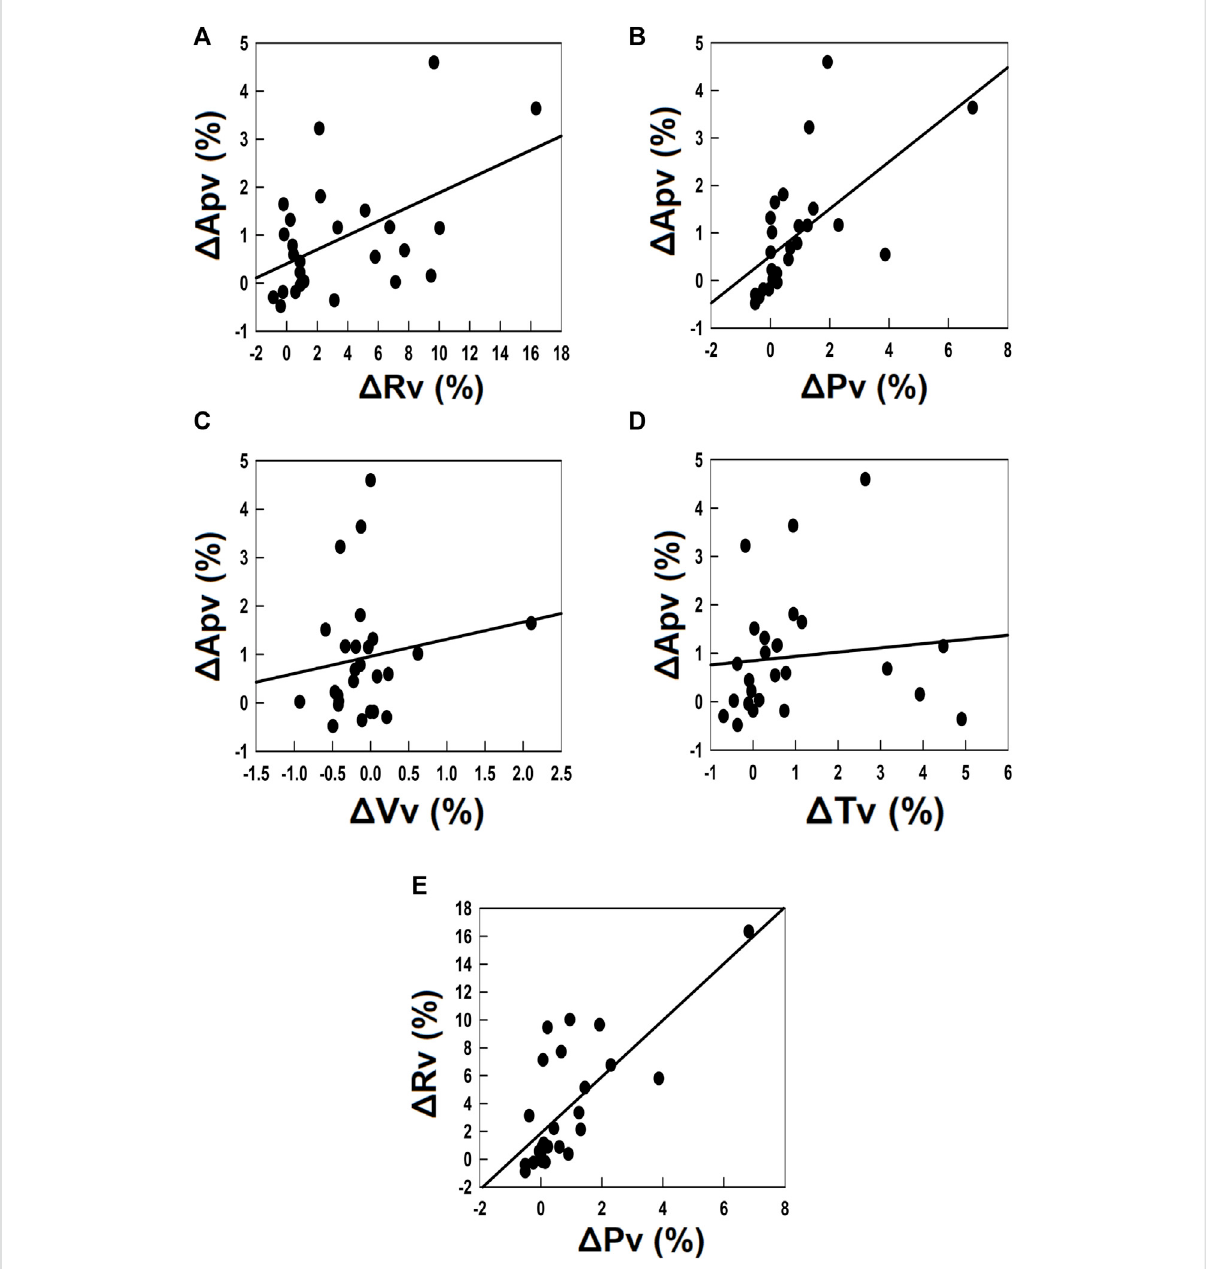
FIGURE 5 Correlation analyses of the TOT-associated change in Apv and changes in voiding parameters. (A – D) correlation analyses of the TOT- associated change in the loop-enclosed area ( Δ Apv) and changes in the mean voiding resistance ( Δ Rv; r > 0.5, N = 26), the mean voiding pressure ( Δ Pv; r > 0.5, N = 26), the voided volume ( Δ Vv; r < 0.3, N = 26), and the voiding time ( Δ Tv; r < 0.3, N = 26), respectively. (E) correlation analysis of Δ Rv and Δ Pv ( r > 0.7, N =